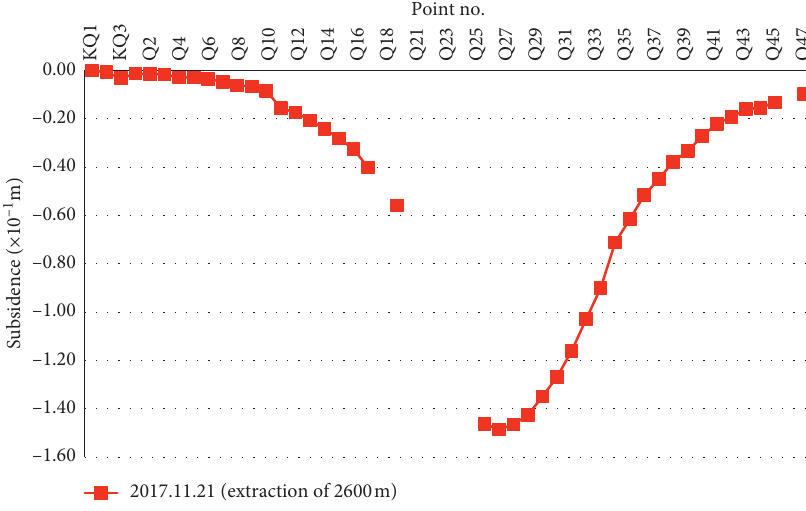
Figure 8: Profile of Line Q along the dip of 31101